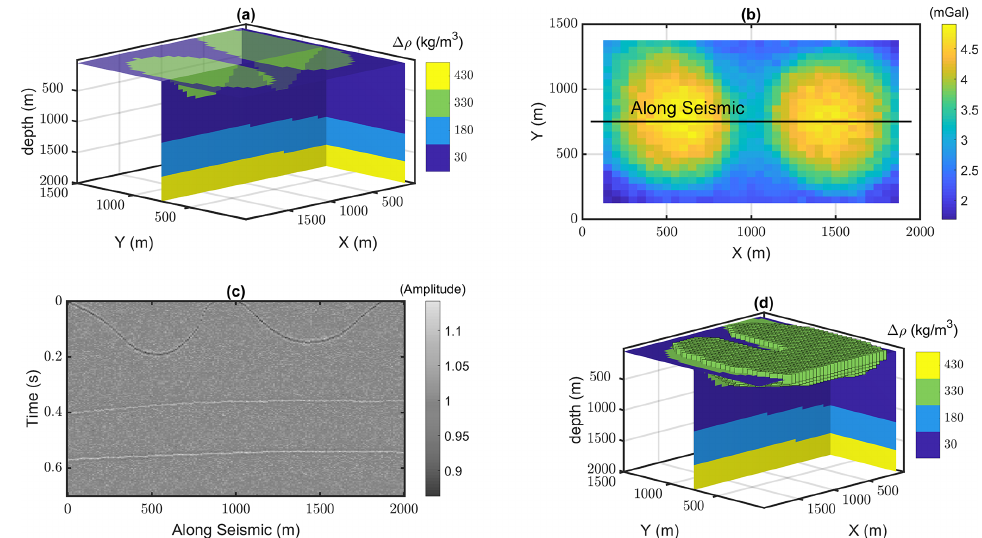
Figure 4. A 3D view of the true model (a) and surface gravity anomaly response (b) , a zero-offset synthetic seismic section (c) , and a 3D view of the starting model (d) .